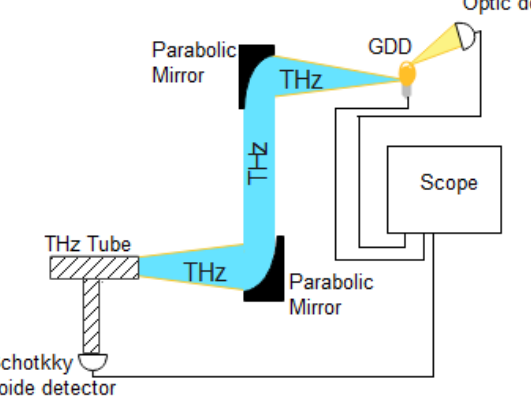
Figure 1. Schematic diagram for 0.1 THz pulse